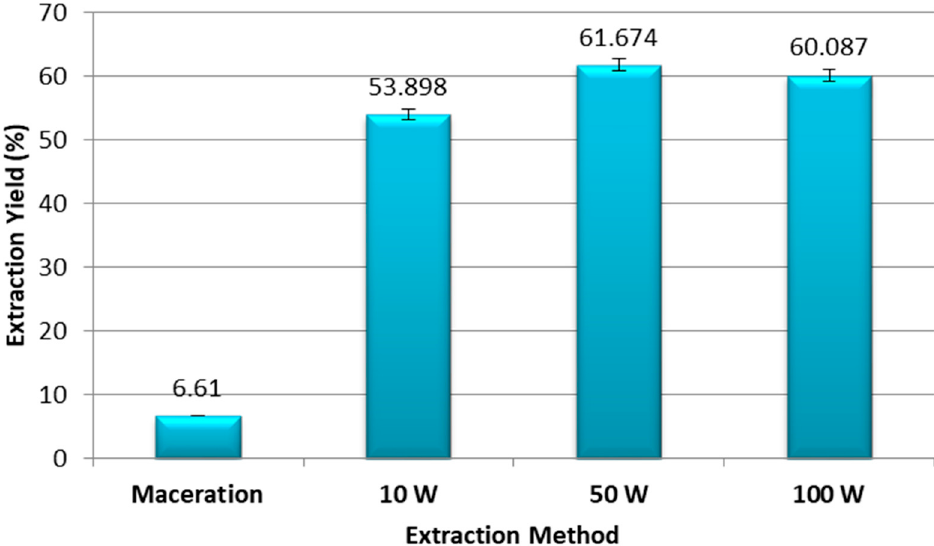
Figure 1. Percentage of extraction yield from ethanolic extracts of pomegranate peel obtained by maceration and ultrasound assisted extraction at 10 W, 50 W, and 100 W. Experiments were repeated three times ( n = 3). Bars display mean ± S.D.